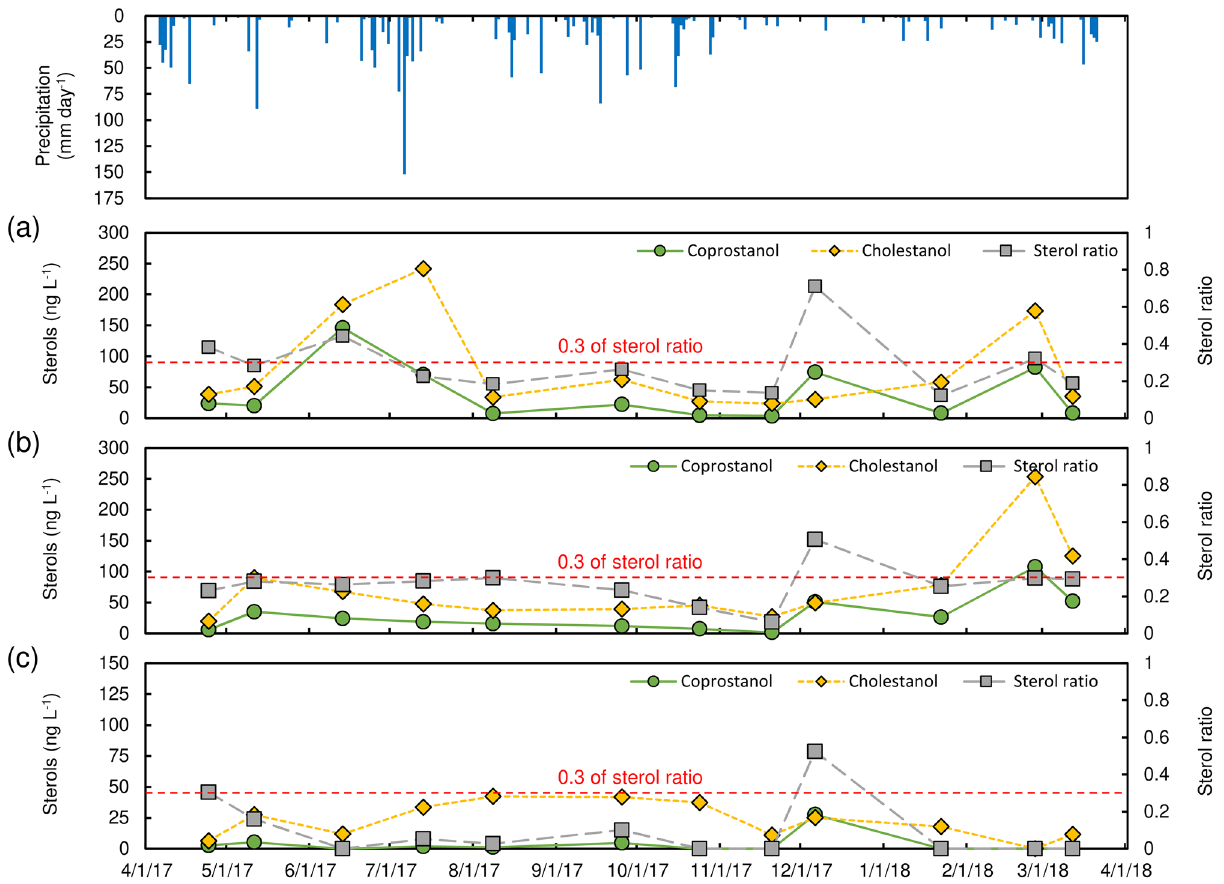
Figure 5. Temporal variation of coprostanol, cholestanol, and sterol ratio in groundwater ( a ) T-1, ( b ) T-2, ( c )